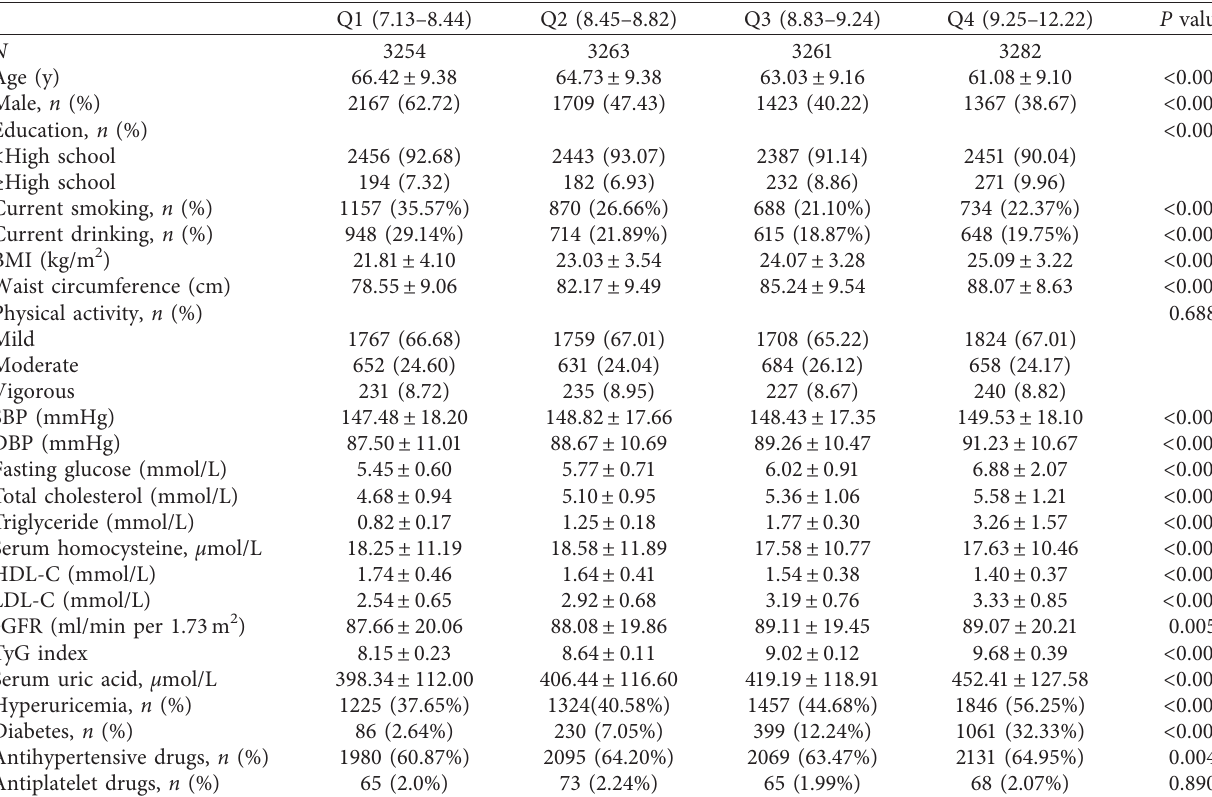
Table 1: Clinical characteristics of the study population according to the TyG index.